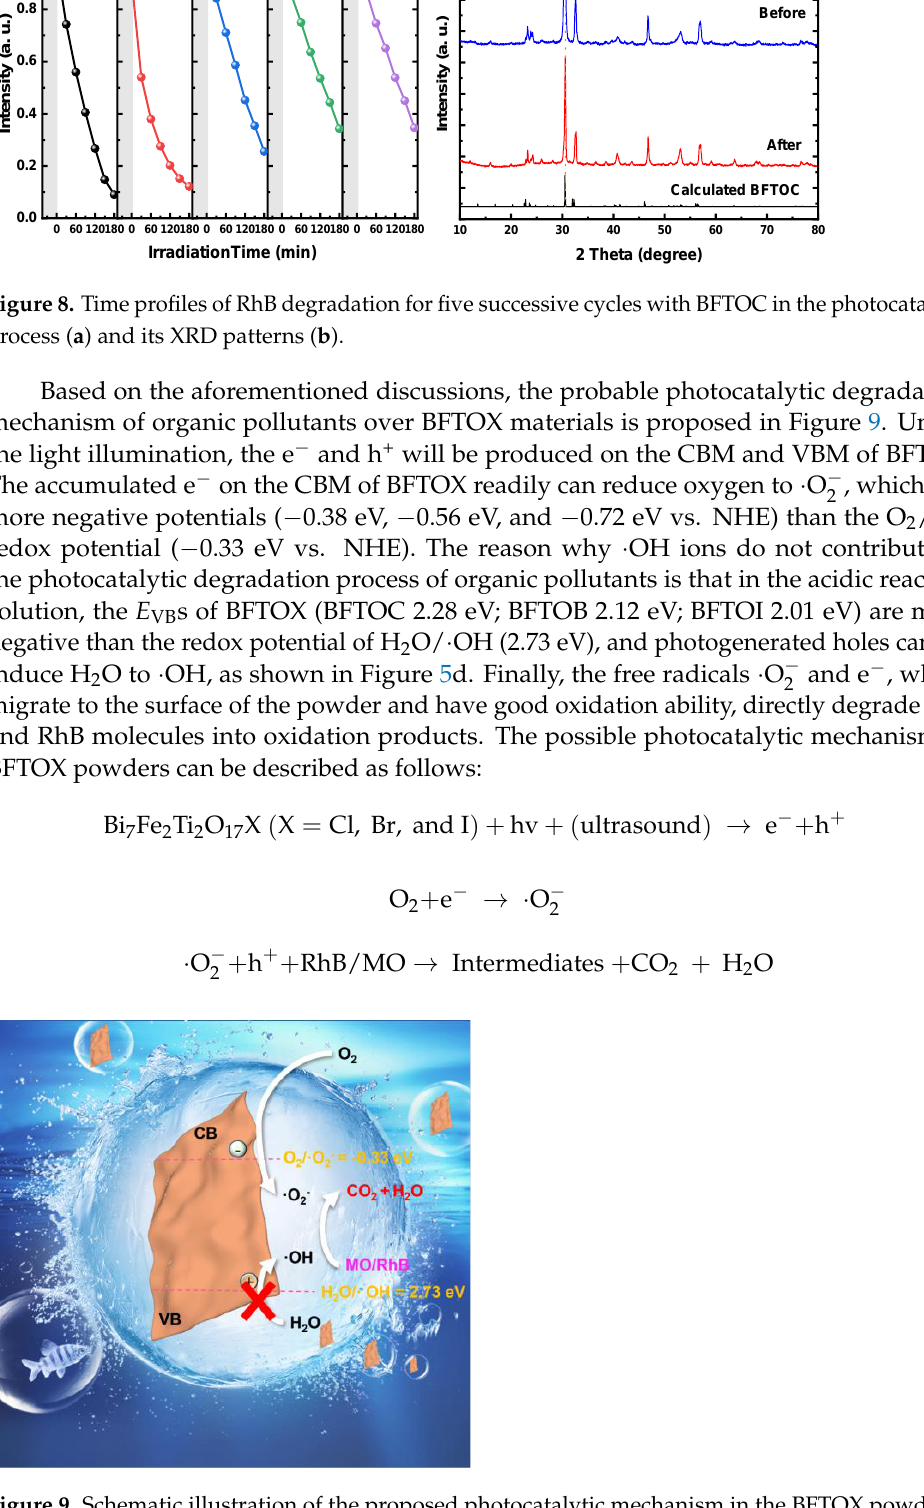
Figure 9. Schematic illustration of the proposed photocatalytic mechanism in the BFTOX powders.